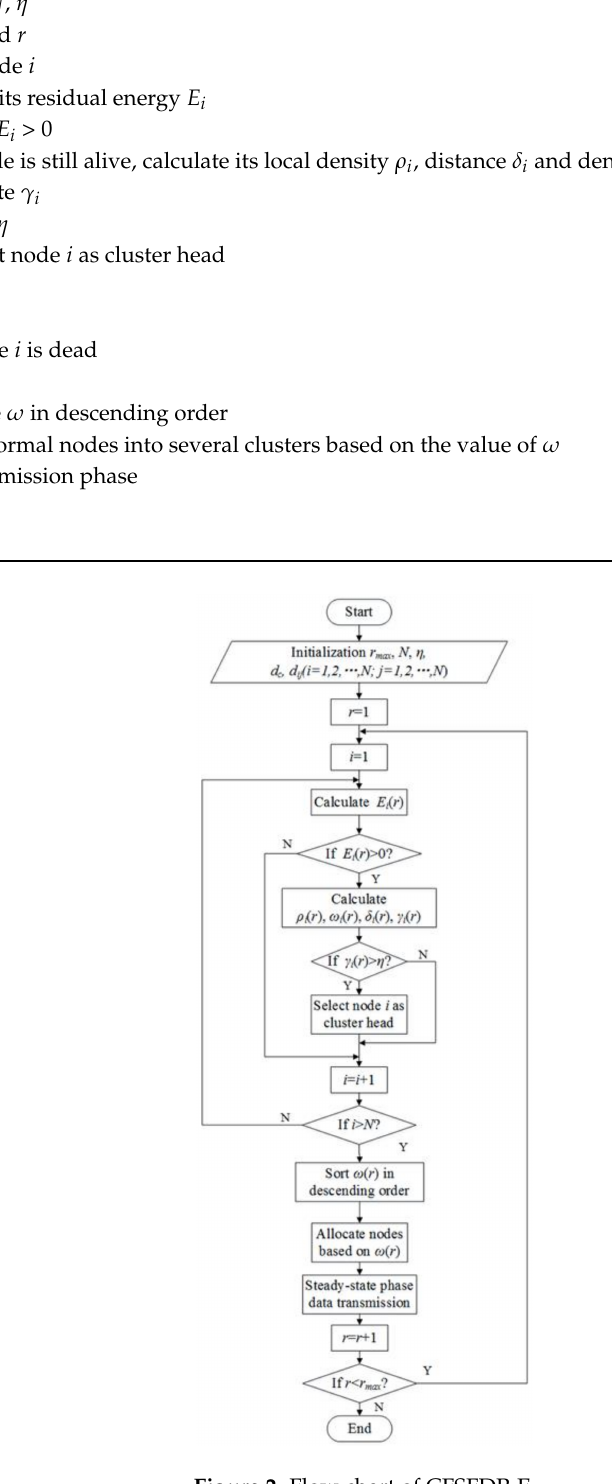
Figure 2. Flow chart of